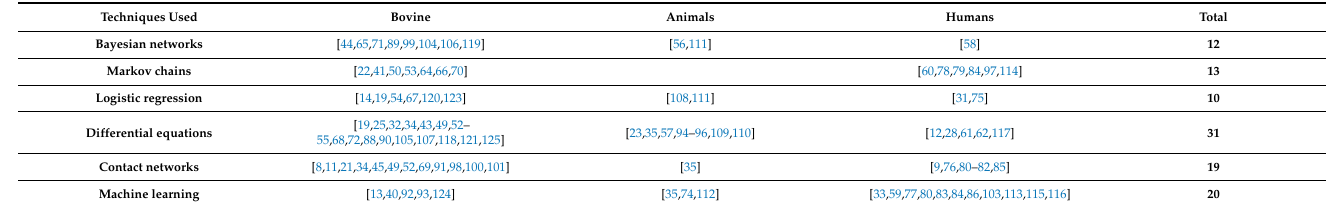
Table 4. Result of comparing related job–techniques used group.